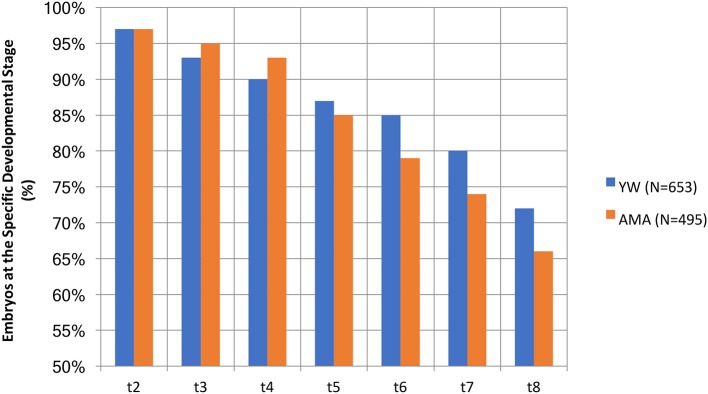
A comparison of the percentage of AMA (study) and YW (control) embryos existing at the specific developmental stage.